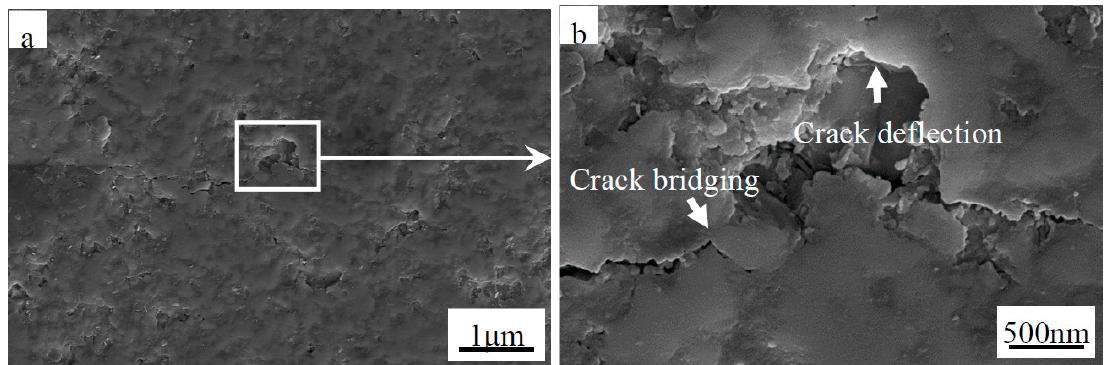
Figure 8. Secondary electron SEM images showing ( a ) an indentation crack for the ZrB 2(nano) -5 wt % CNTs composites; and ( b ) magnified region.